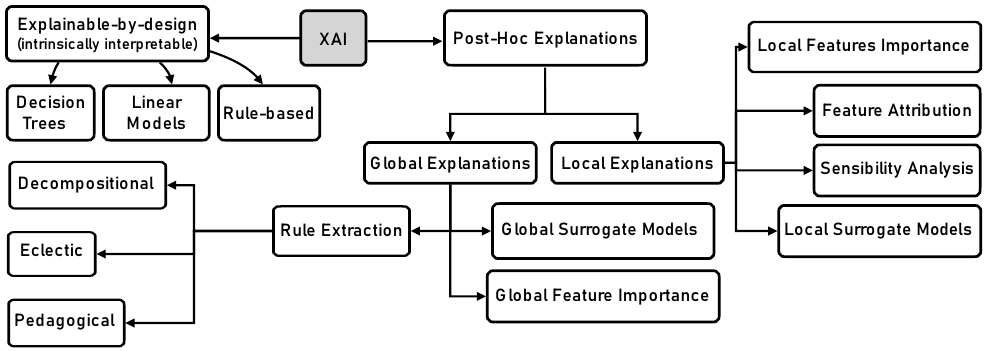
Figure 1. Taxonomy of the XAI classes of